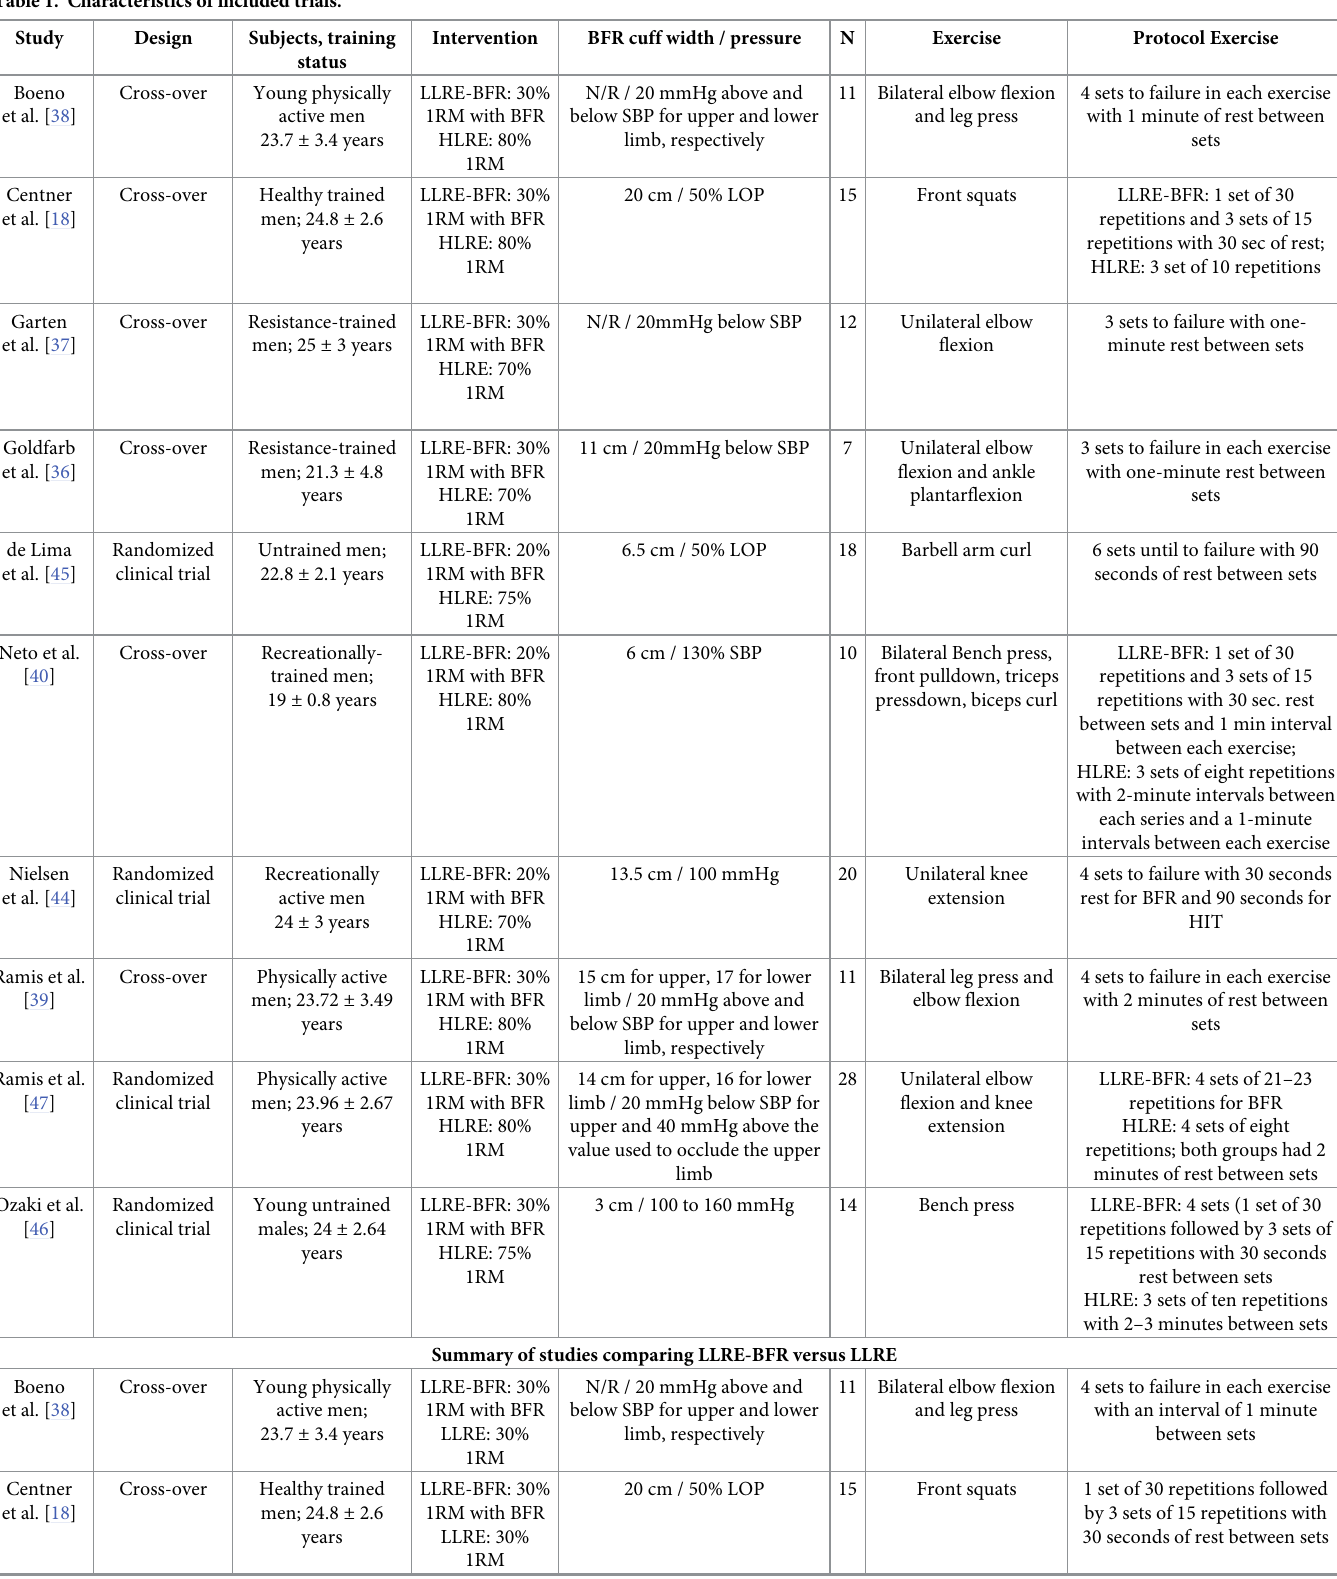
Table 1. Characteristics of included trials.